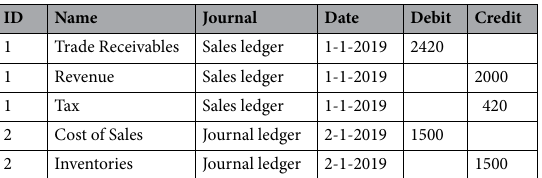
Table 2. Transaction with ID 1 is a Sales transaction and transaction with ID 2 is a Goods dispatch